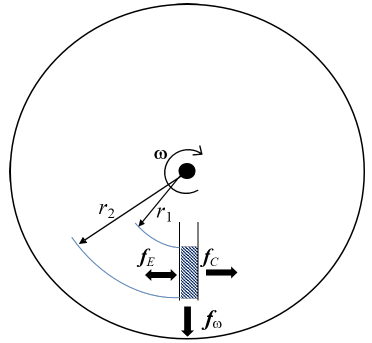
Figure 2. Forces acting in centrifugal microfluidics. The centrifugal force f ω acts radially outward, the Coriolis force f C acts perpendicular to ω and fluid speed, and the Euler force f E is proportional to the angular